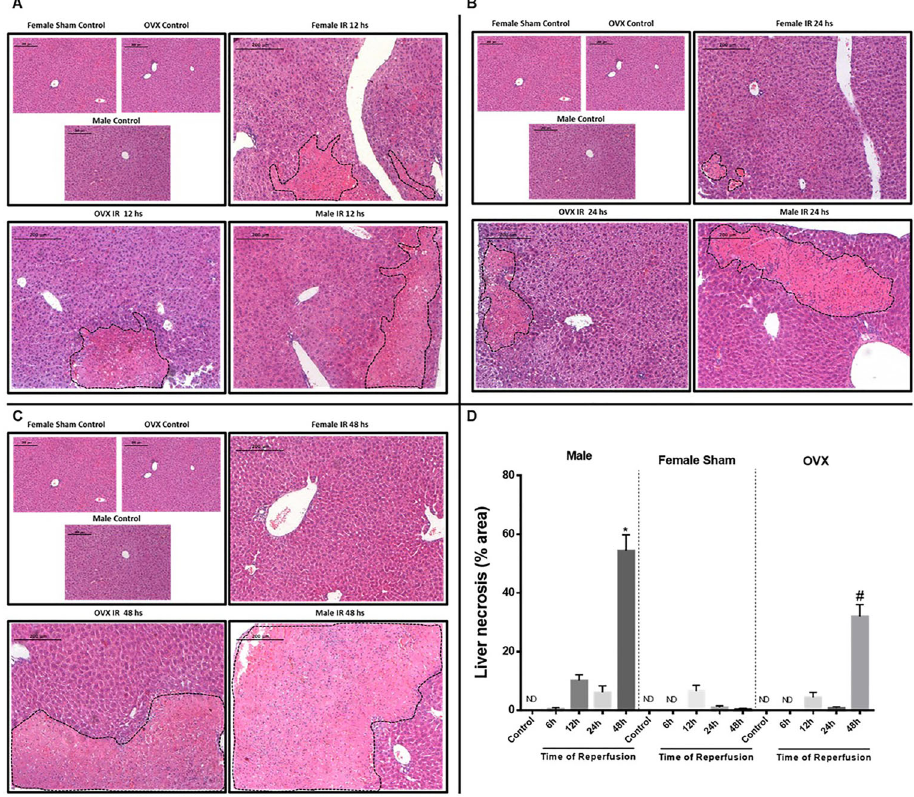
Figure 3. Liver histology at different times of reperfusion among male, female, and ovariectomized (OVX) mice using hematoxylin & eosin (HE) staining ( A – C ). Images were taken with 40 (cid:2) objective, scale bar=200 m m. C , A more severe injury is observed in the liver of male mice subjected to ischemia and reperfusion (IR), especially at 48 h of reperfusion. D , Percent liver necrosis induced by IR. * # P o 0.05 vs male and female sham at 48 h (ANOVA). ND: not detected.